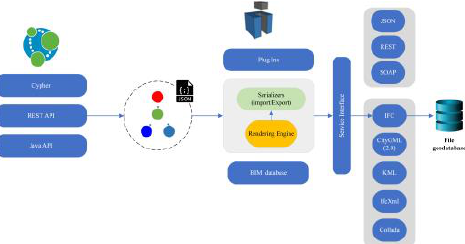
Figure 12. BIMServer Serialization plugins BIM